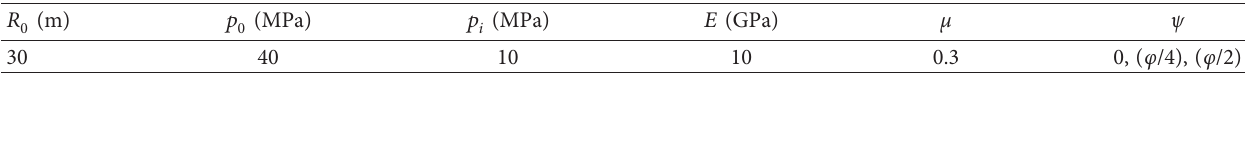
Table 2: H-B parameters of salt rock.